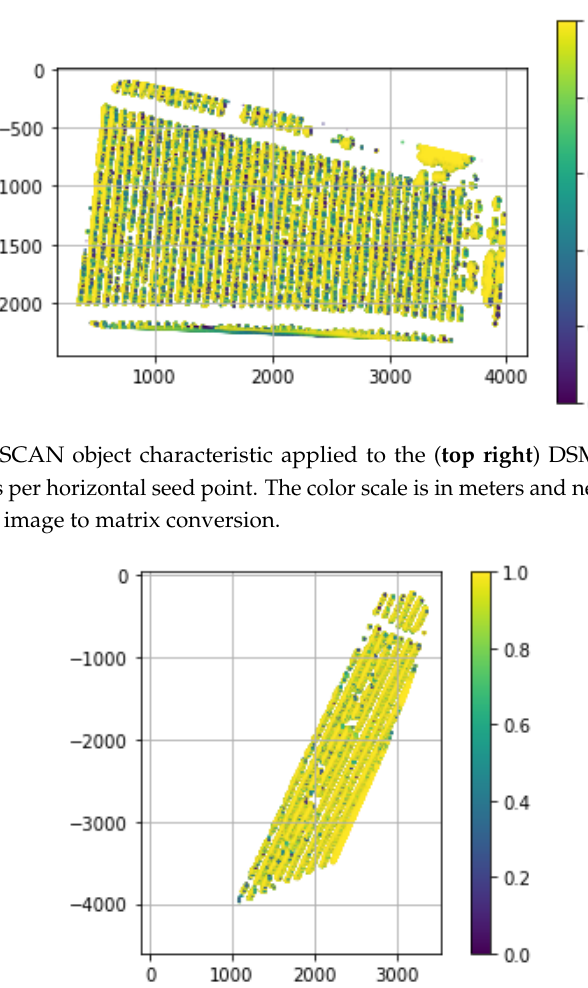
Figure 10. The FANSCAN object characteristic applied to the ( bottom right ) DSM data in Figure 4 at N v = 100 fan rasters per horizontal seed point. The color scale is in meters and negative pixel numbers are an artifact of the image to matrix